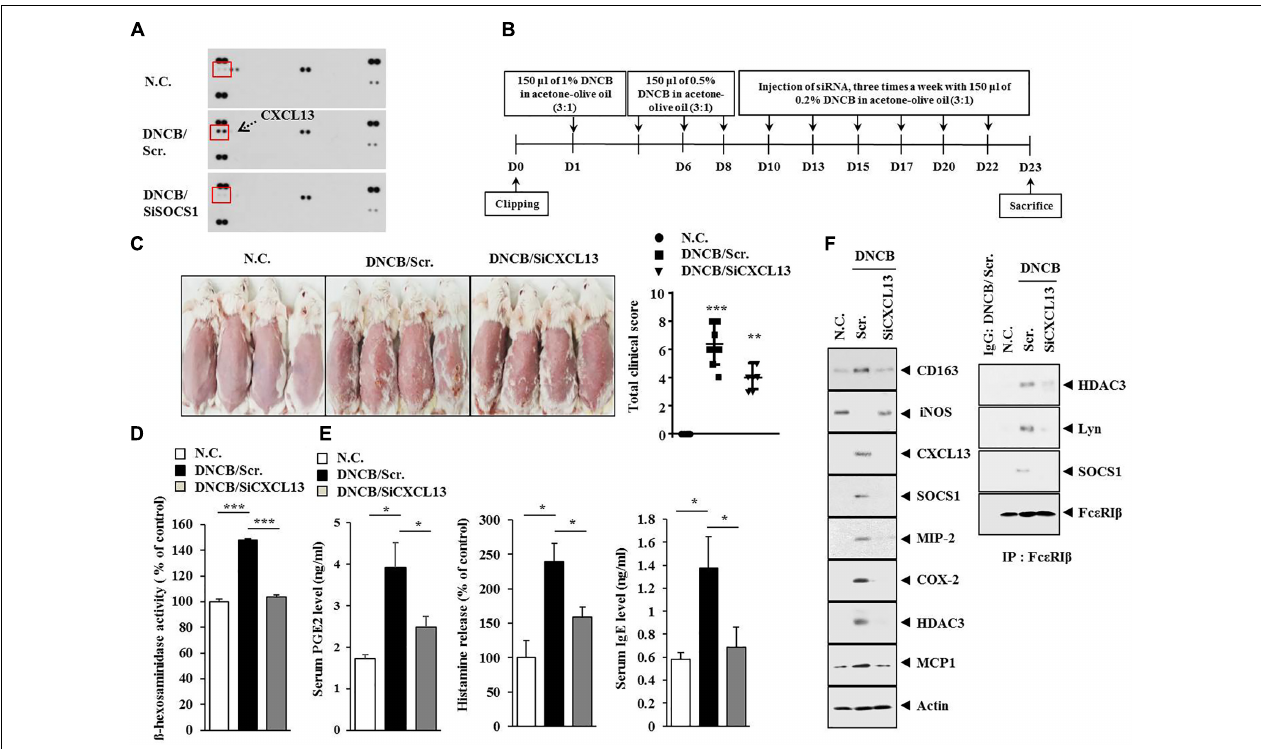
FIGURE 10 | Chemokine (C-X-C motif) ligand 13 (CXCL13) is necessary for DNCB-induced AD. (A) Serum of BALB/c mouse of each experimental group was subjected to cytokine array analyses. Serum was obtained at the time of sacrifice. (B) Shows the experimental time line to determine the effect of CXCL13 on AD. ( C ) At the indicated day after the induction of AD, clinical scores of BALB/c mice of each experimental group were determined. ∗∗ p < 0.005; ∗∗∗ p < 0.0005. (D) Tissue lysates from the mice of each experimental group were subjected to ß-hexosaminidase activity assays. ∗∗∗ p < 0.0005. (E) Sera of mice of each experimental group were employed for the determination of PGE2 level, IgE level, and the amount of histamine released. ∗ p < 0.05. (F) Tissue lysates from the mice of each experimental group were subjected to western blot analysis and immunoprecipitation by employing the indicated antibody (2 µ